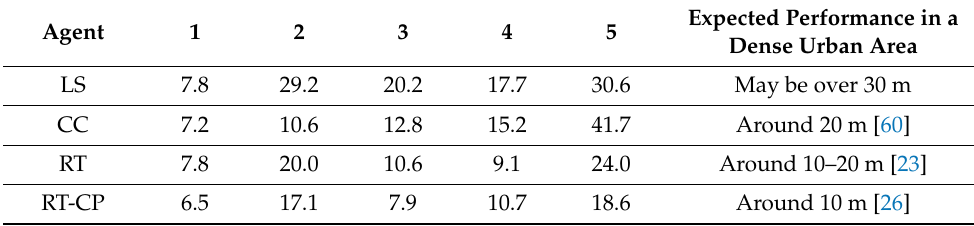
Figure 25. The 2D positioning error of different algorithms corresponding to each agent during the multiagent simulation performance verification. The numbers ( 1 )–( 5 ) are corresponding to Agent 1–5 in Figure 23. Table 6. The root-mean-square error (in meter) of different GNSS positioning algorithms applied on the simulated measurements.